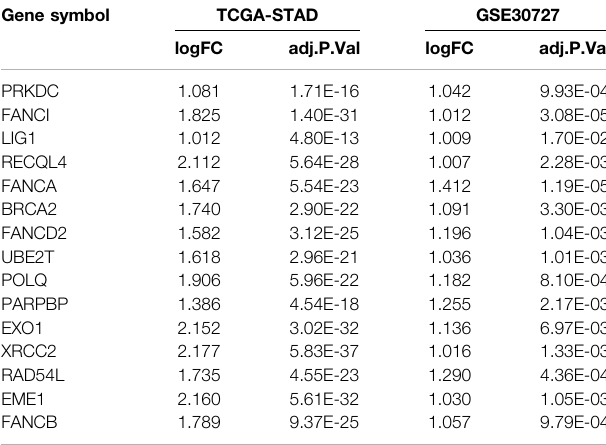
TABLE 1 | The 15 DNA repair genes in the DRGS and their respective